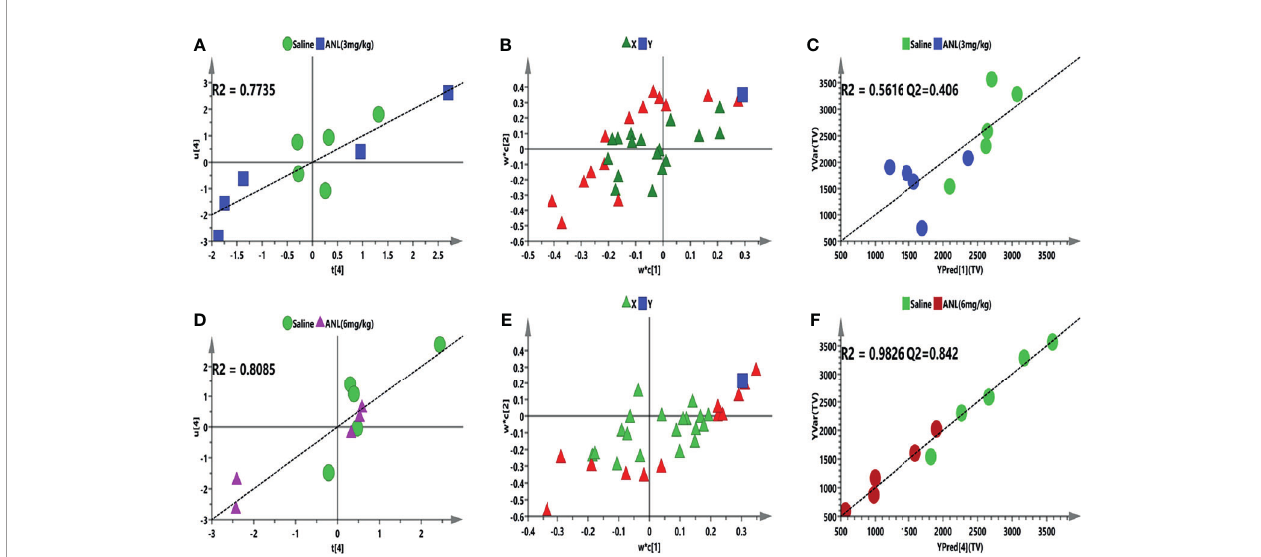
FIGURE 6 | The supervised PLS model for correlating metabolic pro fi les with the ef fi cacy of anlotinib. (A, D) are initial PLS for the fi rst latent variables (ratio of peak area of metabolites, X block) of tumor volume (ANL, 3 mg/kg and 6 mg/kg, Y block) prediction model, respectively. (B, E) are loading plots for tumor volume, respectively. The square (blue) means the response variable; each triangle represents a metabolite, and the triangles (red) show the metabolites with VIP > 1.0. (C, F) are re fi ned models to predict tumor volume based on the screened biomarkers.